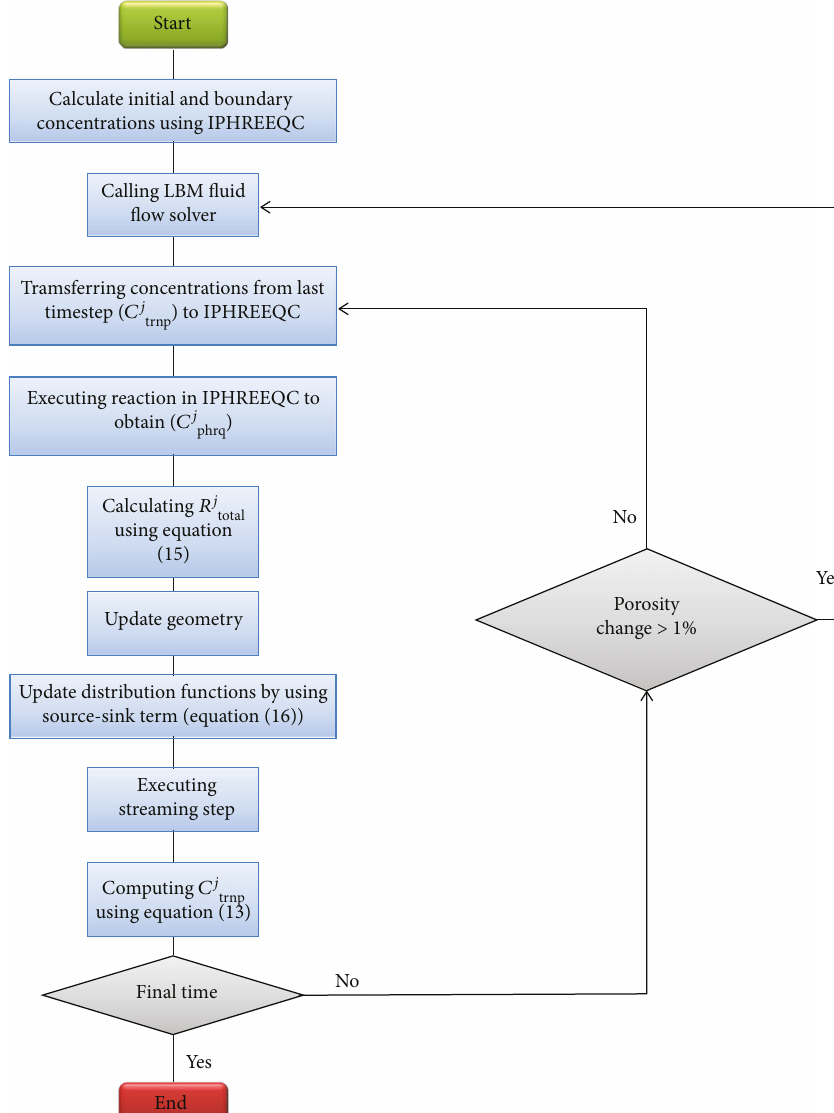
Figure 1: Flowchart of the LBM reactive transport